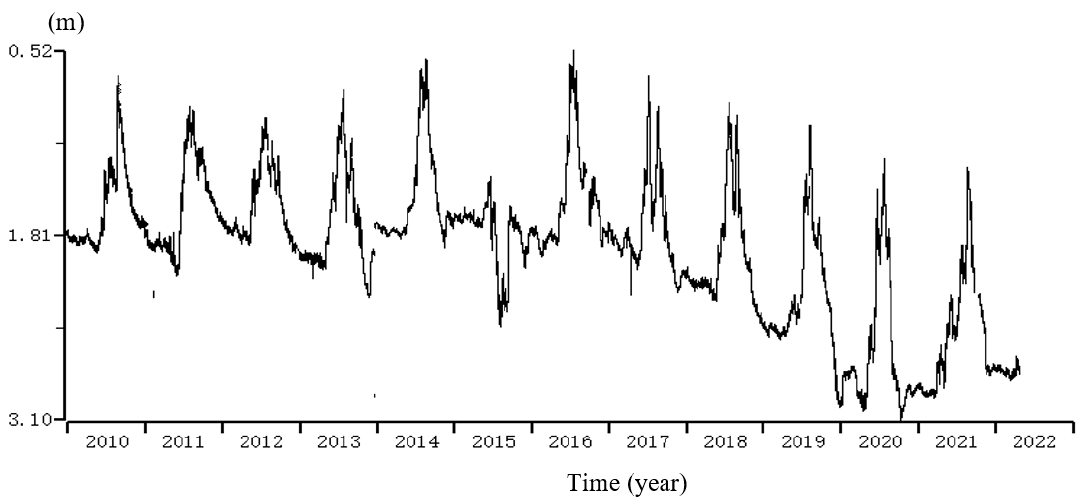
Figure 10. Long-term observation curve of the static water level (unit: m) at the Lhasa geomagnetic station.